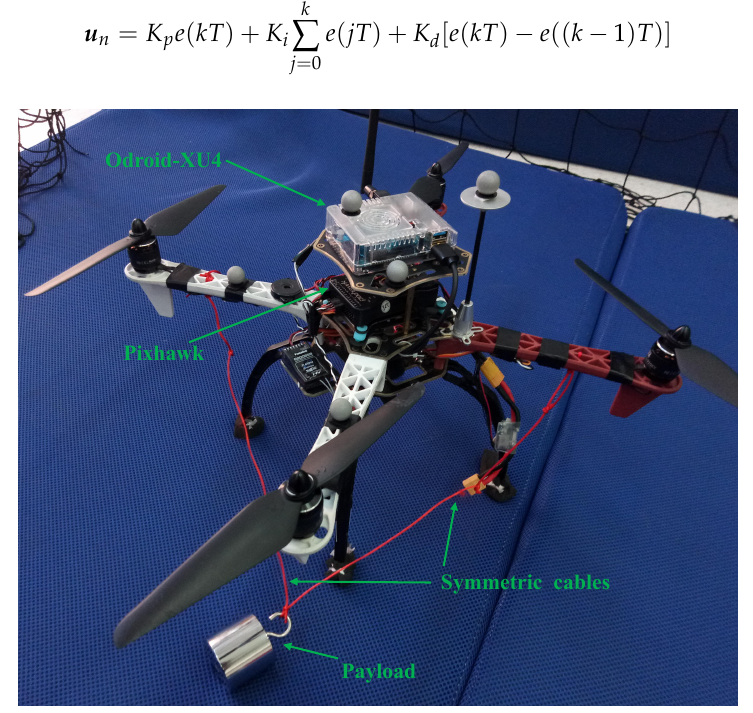
Figure 2. The experimental